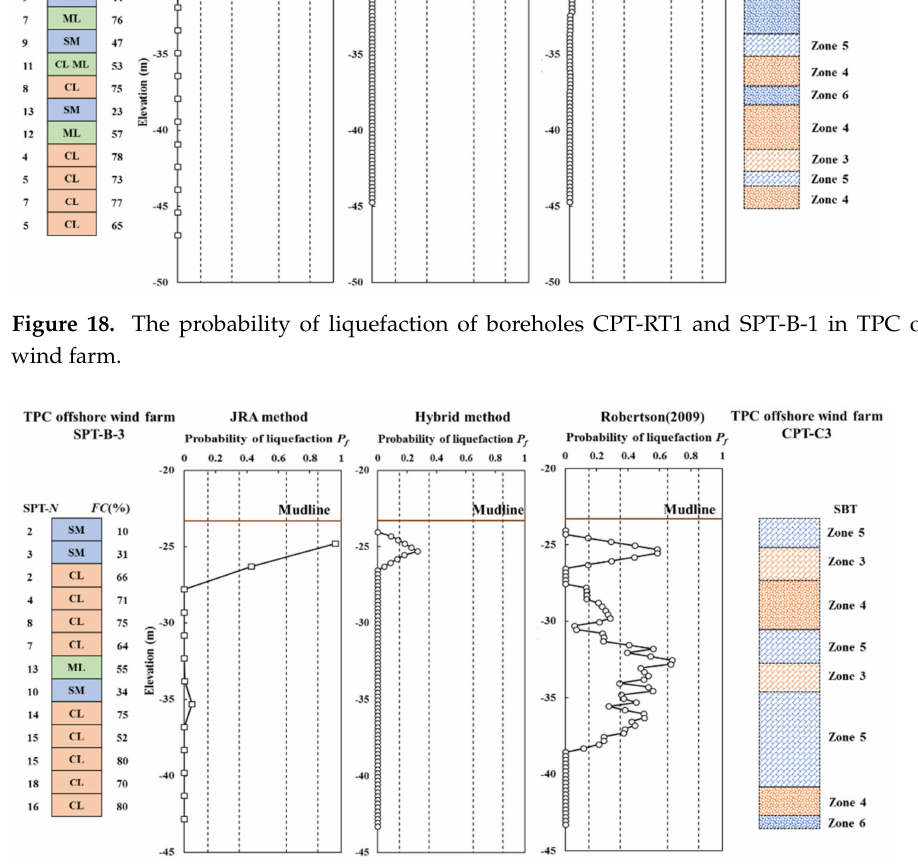
Figure 19. The probability of liquefaction of boreholes CPT-C3 and SPT-B-3 in TPC offshore wind